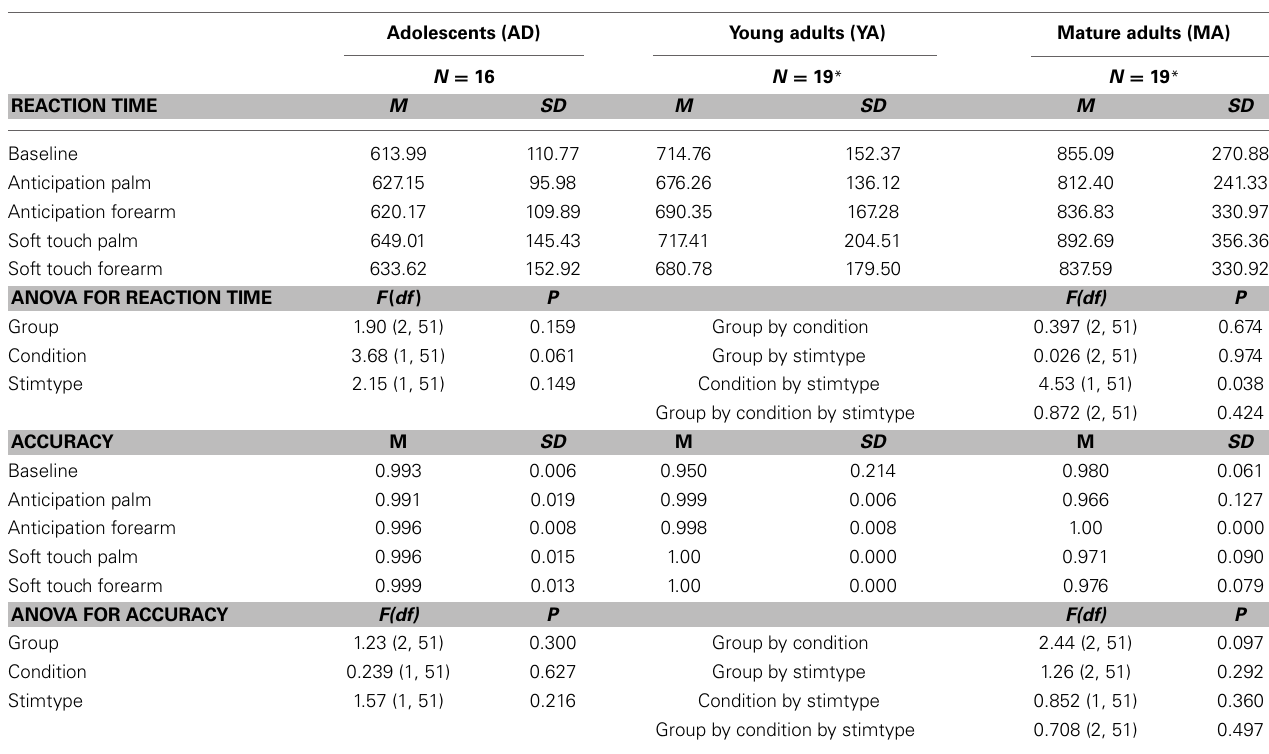
Table 2 | Behavioral data by